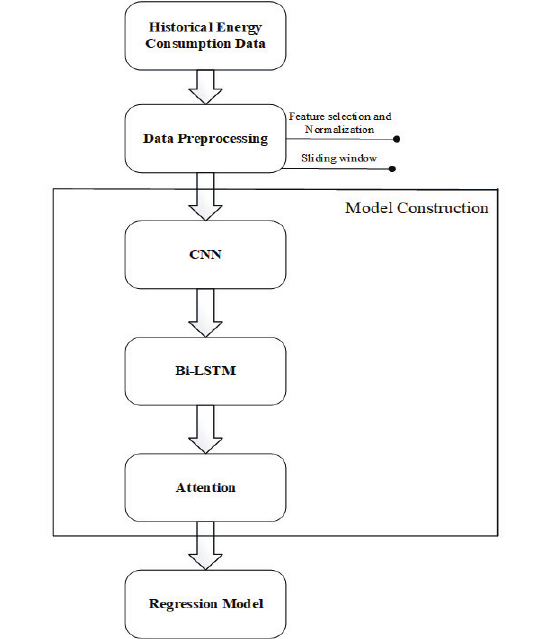
Figure 1. Process of model training for energy consumption